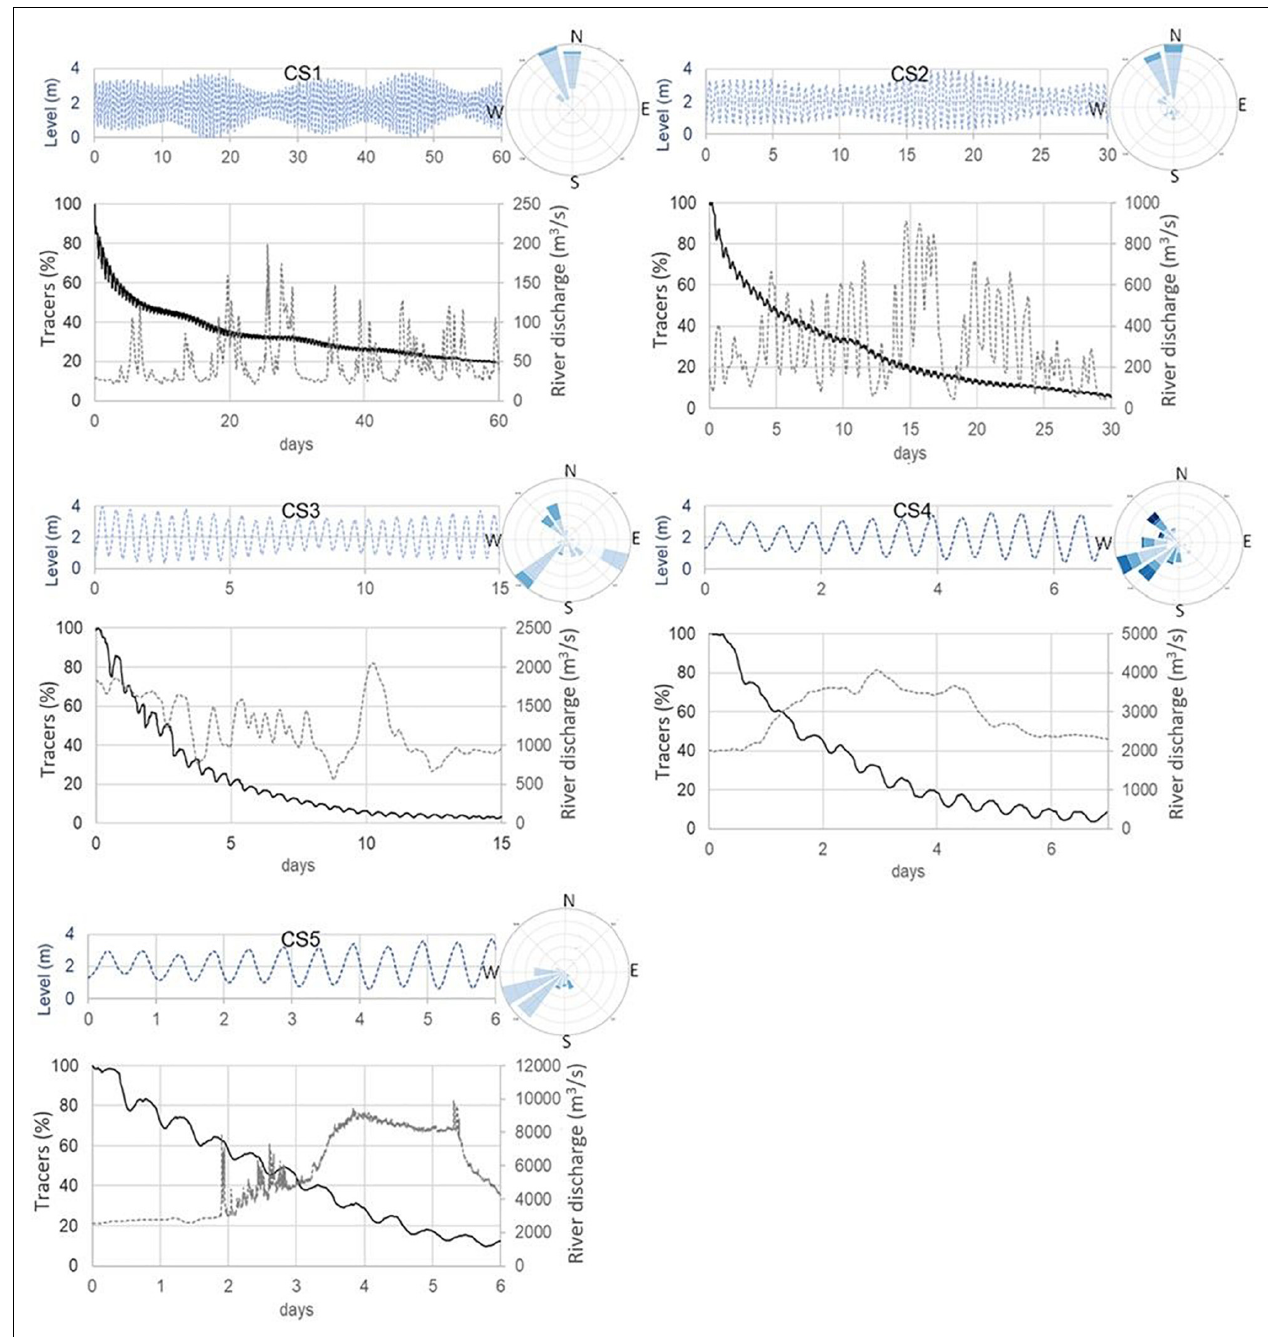
FIGURE 3 | Variation of the proportion of initial tracers over time determined for the whole Tagus estuary and for the five case studies. Real time metocean data (wind, river discharge, and water level) observed during the studied period are also